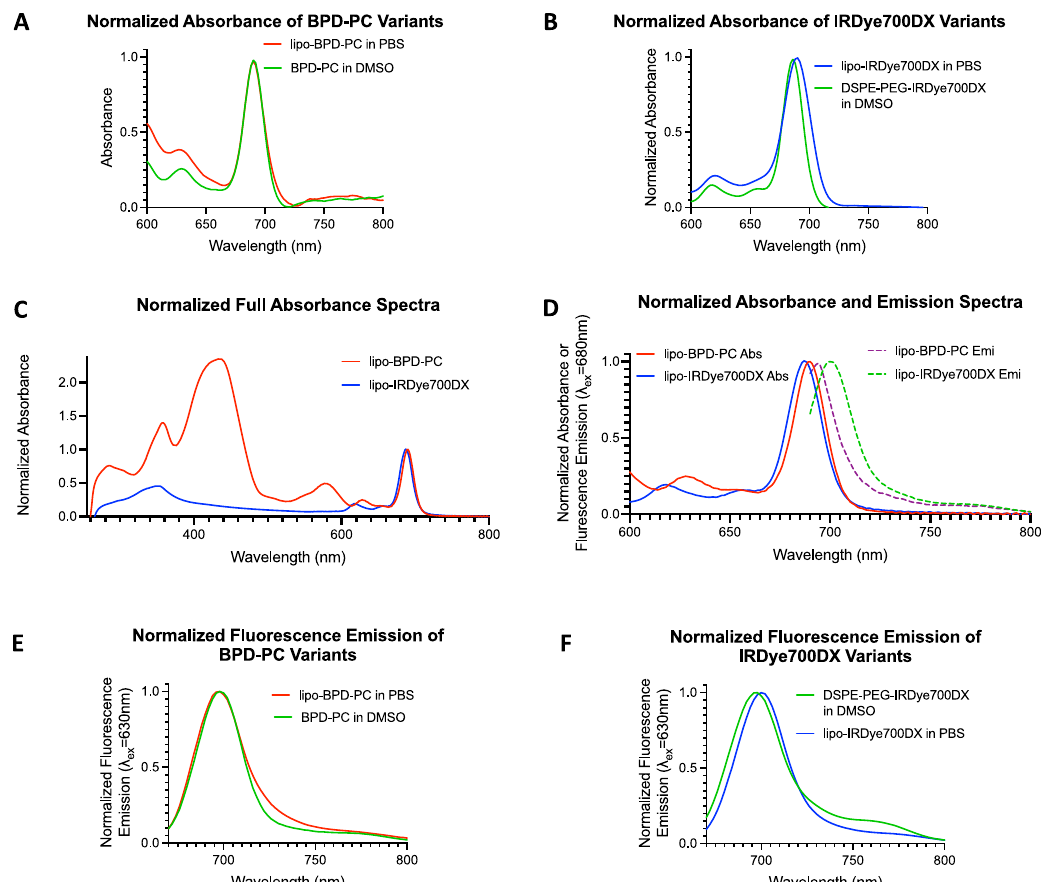
Figure 2: Normalized absorbance spectra of BPD-PC in free form and in liposomal form (A) and of DSPE-PEG-IRDye700DX in free form and in liposomal form (B). (C) Normalized full absorbance spectra of both liposomes reveal the Soret and Q-bands of both PSs. (D) Normalized absorbance andemissionspectra(Exc 680 nm ) of bothliposomesat thered-NIRregion.Normalized fl uorescenceemissionspectraof BPD-PCin free form and in liposomal form (E) and of DSPE-PEG-IRDye700DX in free form and in liposomal form (F) using Exc 630 nm to reveal the full emission band pro fi les and to simulate the excitation of the in vivo fl uorescence imaging system.